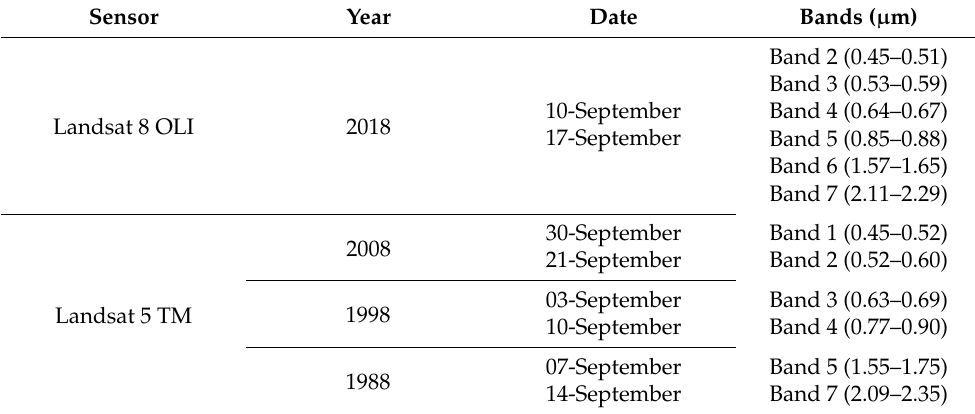
Table 1. Landsat images used for land cover classification.